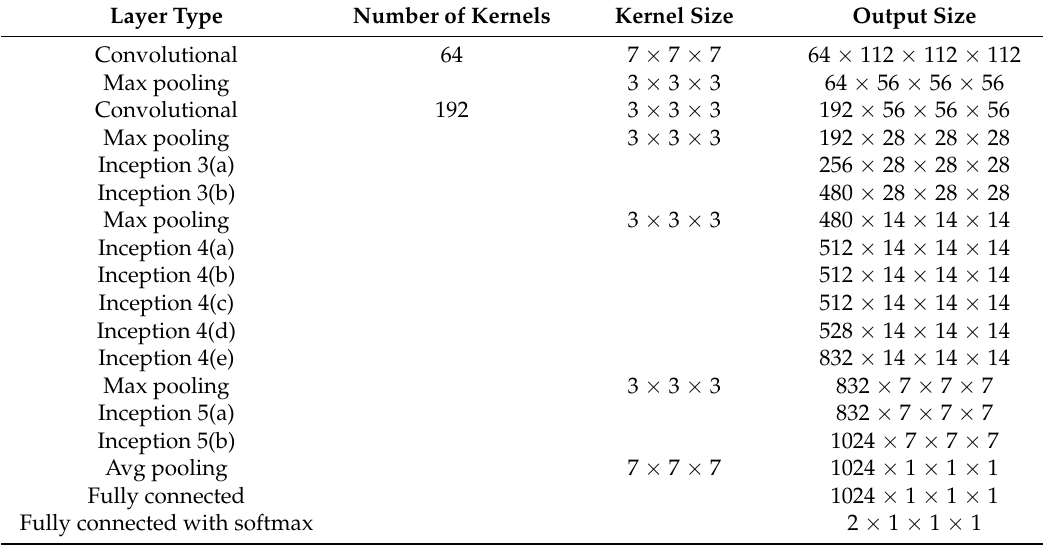
Table 3. Summary of GoogleNet architecture in the classification of lung CT scan